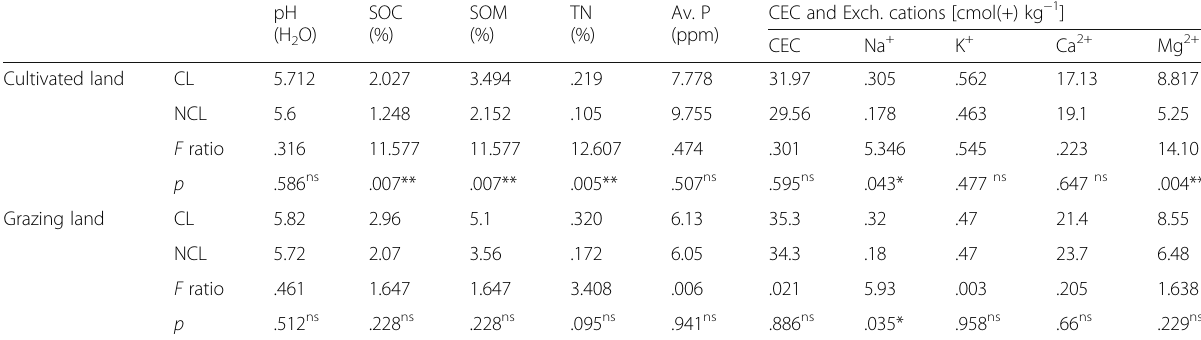
Table 5 The effect of SWC practices on soil chemical properties in different land uses (cultivated and grazing